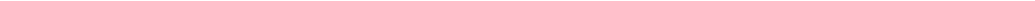
(see fi gure on previous page) Fig. 2 Changes in chromatin states around differentially expressed miRNAs between C2C12 myoblasts and myotubes. a Integrative genomics viewer visualization of intensities of ATAC-seq and ChIP-seq surrounding the mir133a-1, mir1a-2, mir1968, and novel_mmu_mi_9 gene loci and the expression patterns of these miRNAs. b Boxplots showing the fold change patterns of normalized ATAC-seq intensities. c Statistics of colocalization of ATAC-seq-de fi ned open chromatin regions and TF binding. d Motif enrichment analysis of open chromatin regions without colocalization of MyoD or MyoG binding. e Statistics of open chromatin region colocalization with MyoD or MyoG binding. f Expression of TFs enriched in (D) by RNA-seq. g Boxplot of ChIP-seq intensities of MyoD in the genomic region ~±10 kb around the pri-miRNA loci of differentially expressed miRNAs and random non-differentially expressed miRNAs in C2C12 myoblasts cultured in GM (0D) and then in DM for 60 h (2.5D). h Scatter plot showing normalized ChIP-seq intensities of MyoG binding surrounding the ~±10 kb genomic region around the pri-miRNA loci of differentially expressed miRNAs in C2C12 myoblasts cultured in GM (0D) and then in DM for 60 h (2.5D). i Motif enrichment in MyoD and MyoG- colocalized regions. * p < 0.05; ** p <